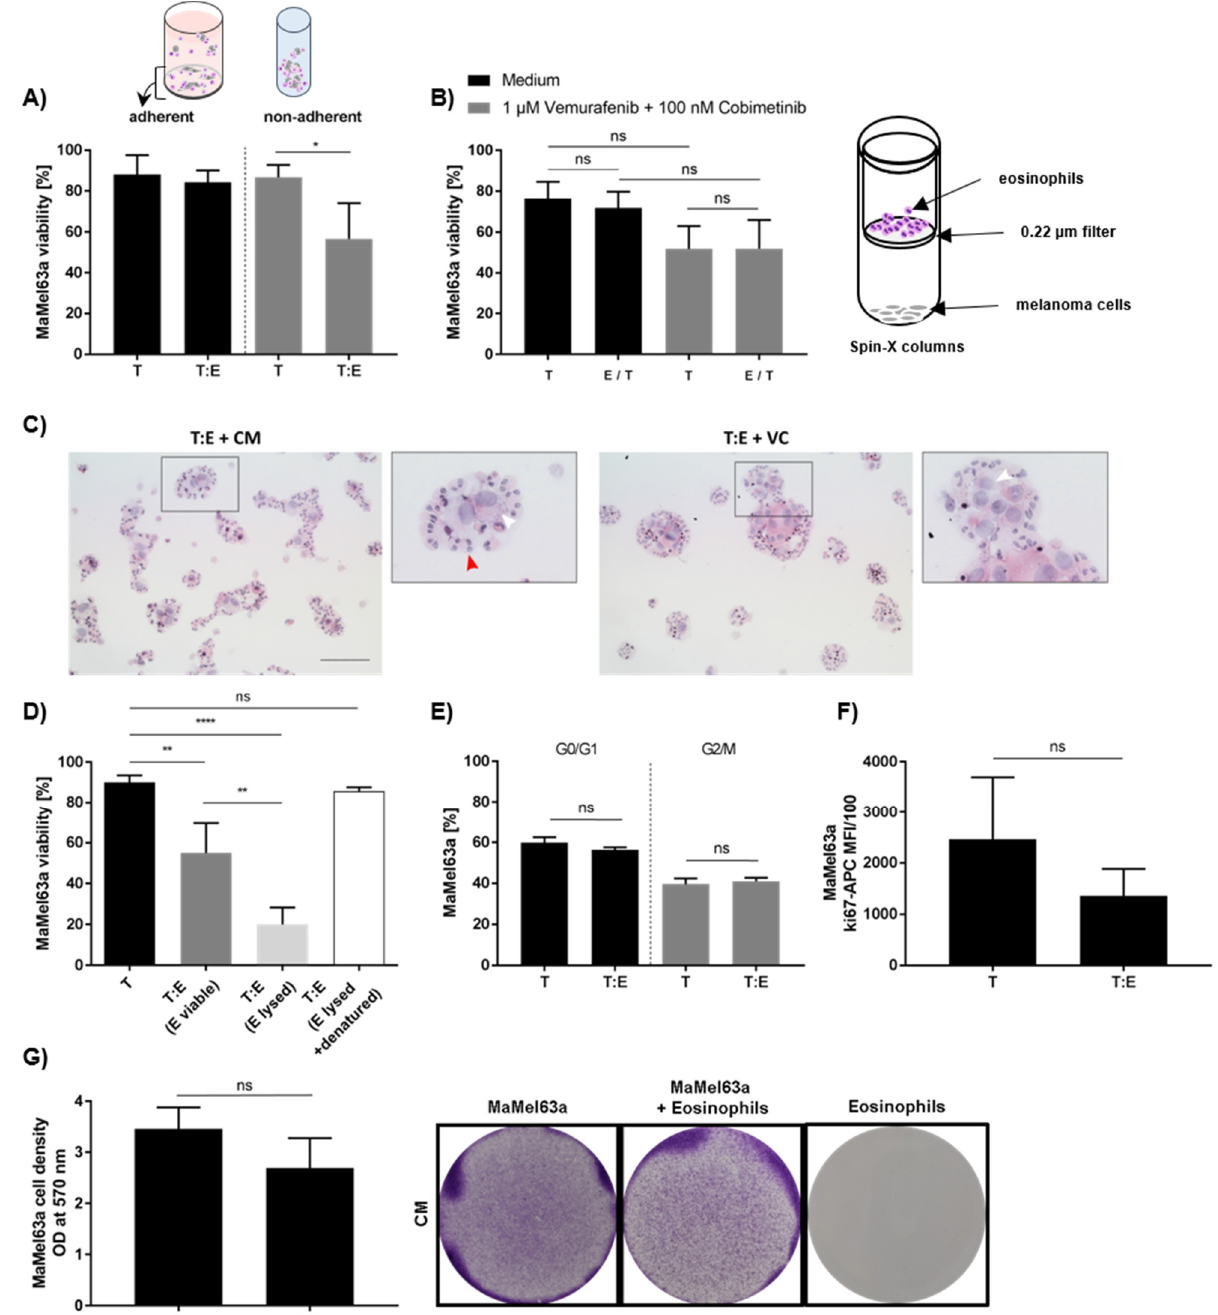
Figure 6. Unraveling the interaction of melanoma cells and blood-derived eosinophils. ( A ) MaMel63a cells were co-cultured with eosinophils for 48 h. Separate measurement of viability of adherent (24-well plate) and non-adherent (polypropylene tube) melanoma cells. Cytotoxicity depends on culture condition. Melanoma cell killing by eosinophils is only observed under unattached conditions. ( B ) Physical proximity is crucial for the functionality of eosinophils in co-cultures. Separate co-cultures of MaMel63a cells with eosinophils in Spin-X ® columns containing a semipermeable membrane (pore size 0.22 µm) for 24 h. Culture with or without 1 µM vemurafenib and 100 nM cobimetinib. The cytotoxic effect could not be maintained when cells were cultured separately. ( C ) Cytospins of co-cultures stained for HE. Eosinophils and MaMel63a cells form aggregates after 24 h of culture. Red arrows indicate intact eosinophils. Black square in original image indicate the magnified (3.2×) image. The white arrows indicate melanoma cells. 100 µm scale bar. ( D ) Tumoricidal function of eosinophils towards melanoma cells is an active process. Preventing signal transduction in co-cultures by lysis (1 min liquid nitrogen treatment of eosinophils